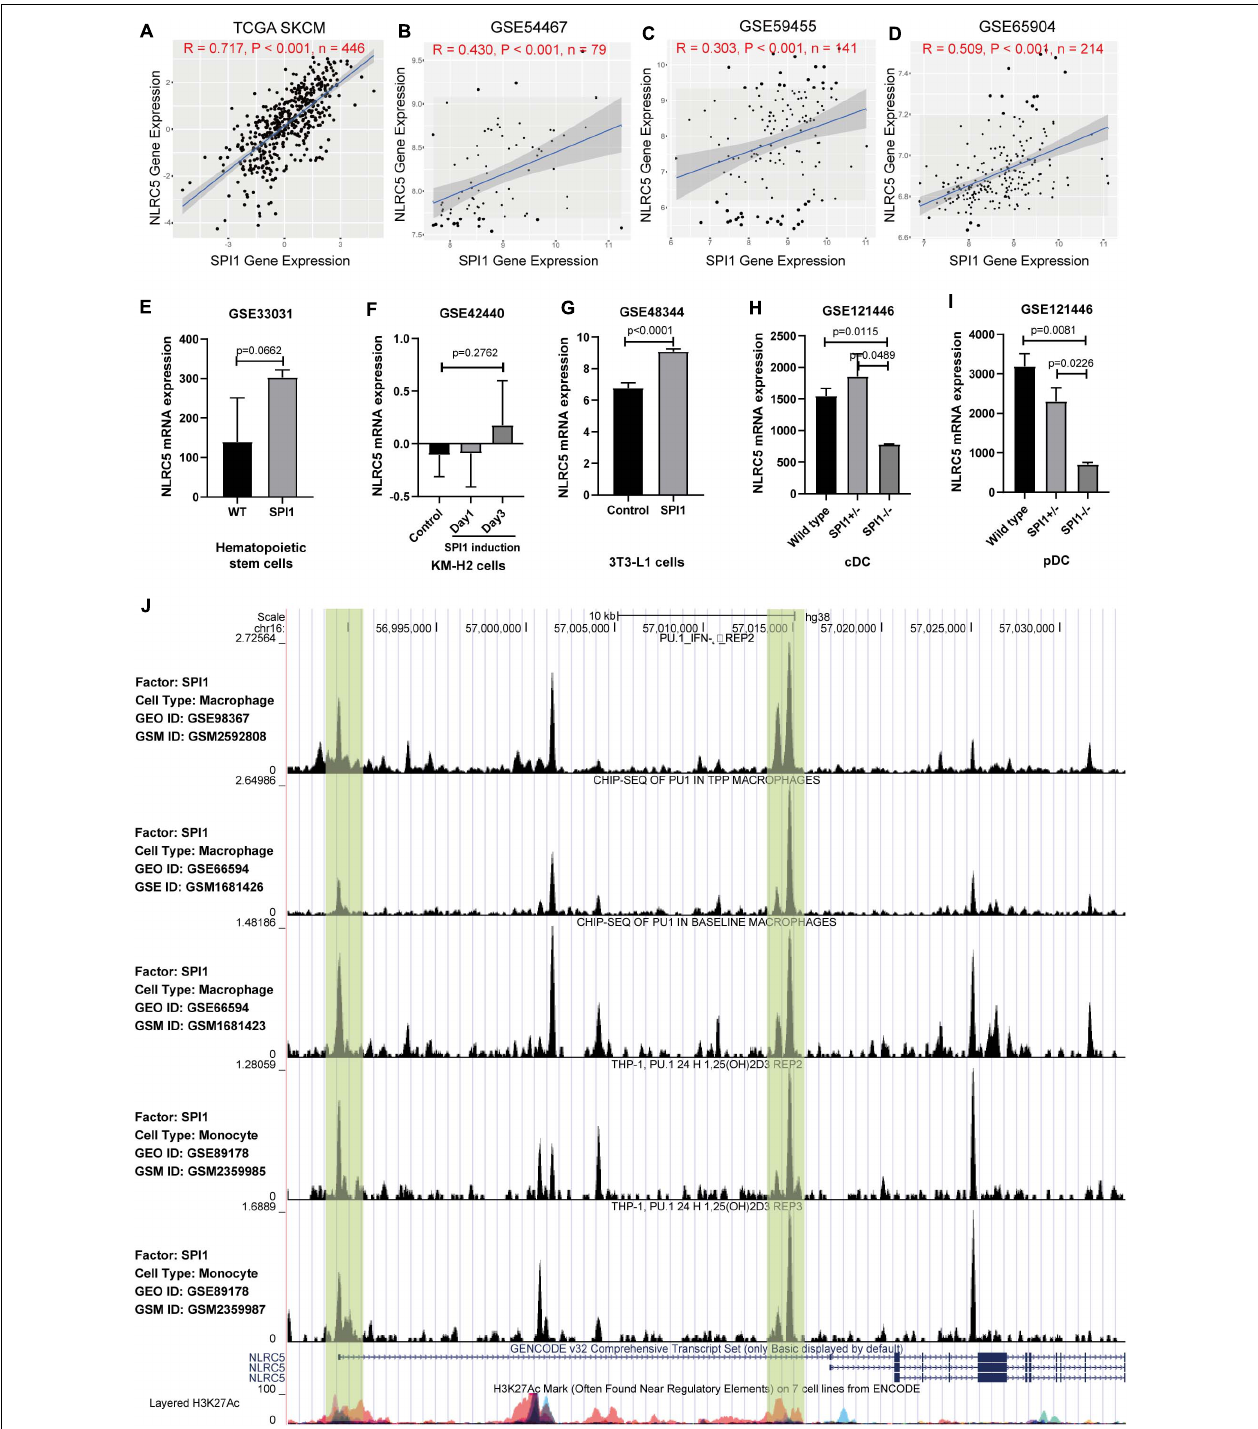
FIGURE 3 | The expression of NLRC5 is regulated by SPI1. (A–D) Spearman correlation analysis of NLRC5 expression with SPI1 expression in TCGA SKCM, GSE54467, GSE59455, and GSE65904 melanoma datasets, respectively. Spearman r and p -value for each correlation are shown. (E) SPI1 knock-in in mouse hematopoietic stem cells (HSCs) promoted NLRC5 expression (reanalysis from GSE33031). (F) NLRC5 expression increased after induction of SPI1 in human KM-H2 cells (reanalysis from GSE42440). (G) SPI1 overexpression in mouse 3T3-L1 promoted the NLRC5 expression (reanalysis from GSE48344). (H,I) Knockout of SPI1 in mouse conventional dendritic cells (cDC) and plasmacytoid dendritic cells (pDC) significantly reduced the NLRC5 expression (reanalysis of GSE121446). (J) SPI1 ChIP-seq data in the GEO platform shows that SPI1 binds to the promoter and first intron of NLRC5 gene (Re-analysis of GSE98367, GSE66594, and